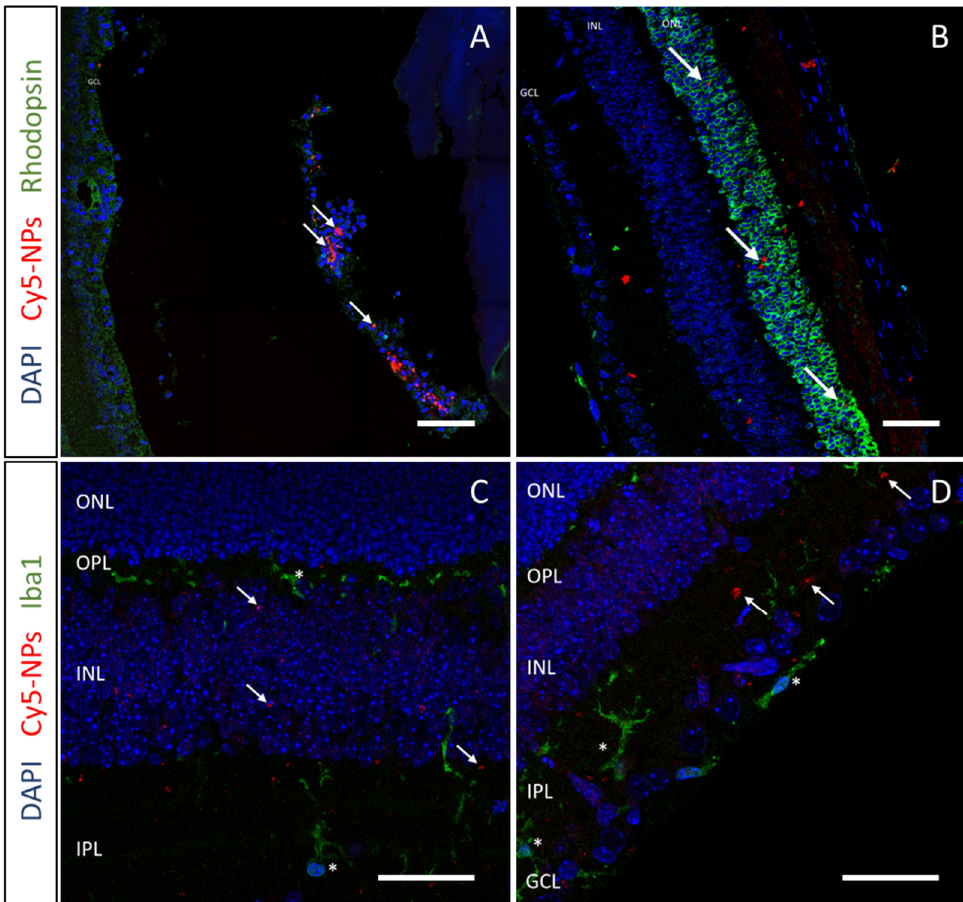
Figure 2. In vivo biodistribution study. Confocal images of sagittal eye sections after intravitreal injection of ( A ) uncoated NPs, ( B ) HA12-coated NPs. Red: Cy5-labeled NPs; Blue: DAPI-labeled nuclei; Green: Rhodopsin labelling photoreceptors. ( C ), ( D ) Evaluation of microglia in retinal tissue after injection of HA12-coated NPs. Red: Cy5-labeled NPs; Blue: DAPI-labeled nuclei; Green: Iba-1 labelling microglia cells. Scale bar 40 µm. Arrows indicate NPs, stars indicate Iba-1-positive cells. ONL: Outer nuclear layer; OPL: Outer plexiform layer; INL: Inner nuclear layer; IPL: Inner plexiform layer; GCL: Ganglion cell layer.